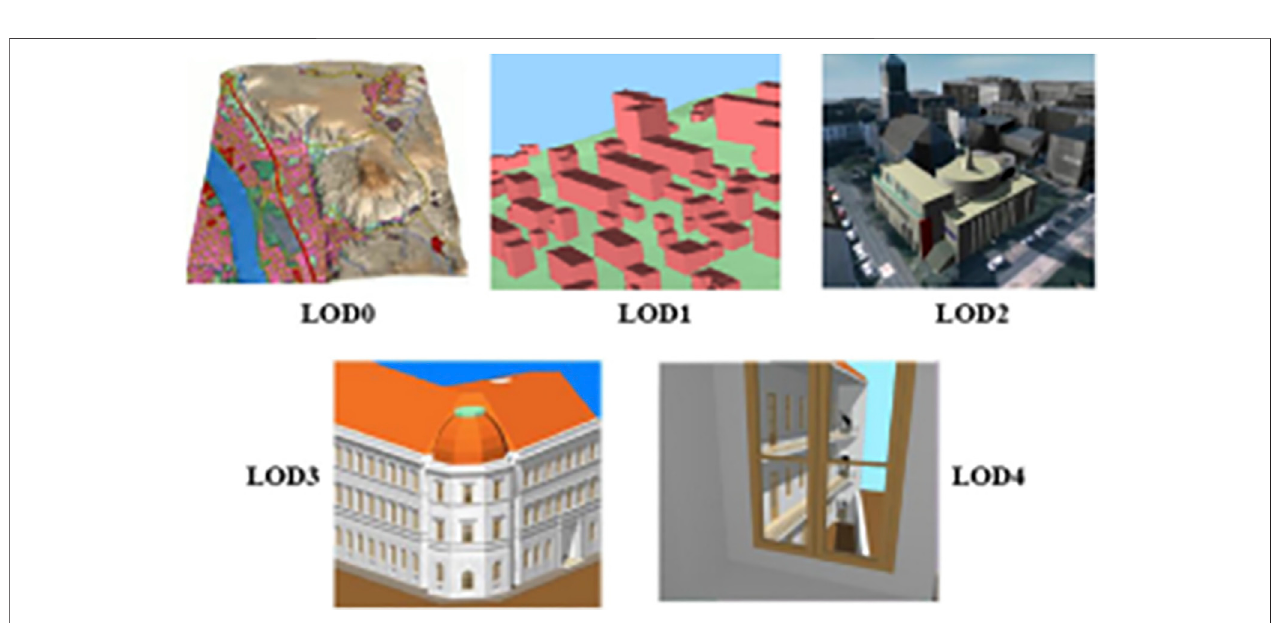
FIGURE 4 | LODs of various 3D building models (Gröger et al., 2008)